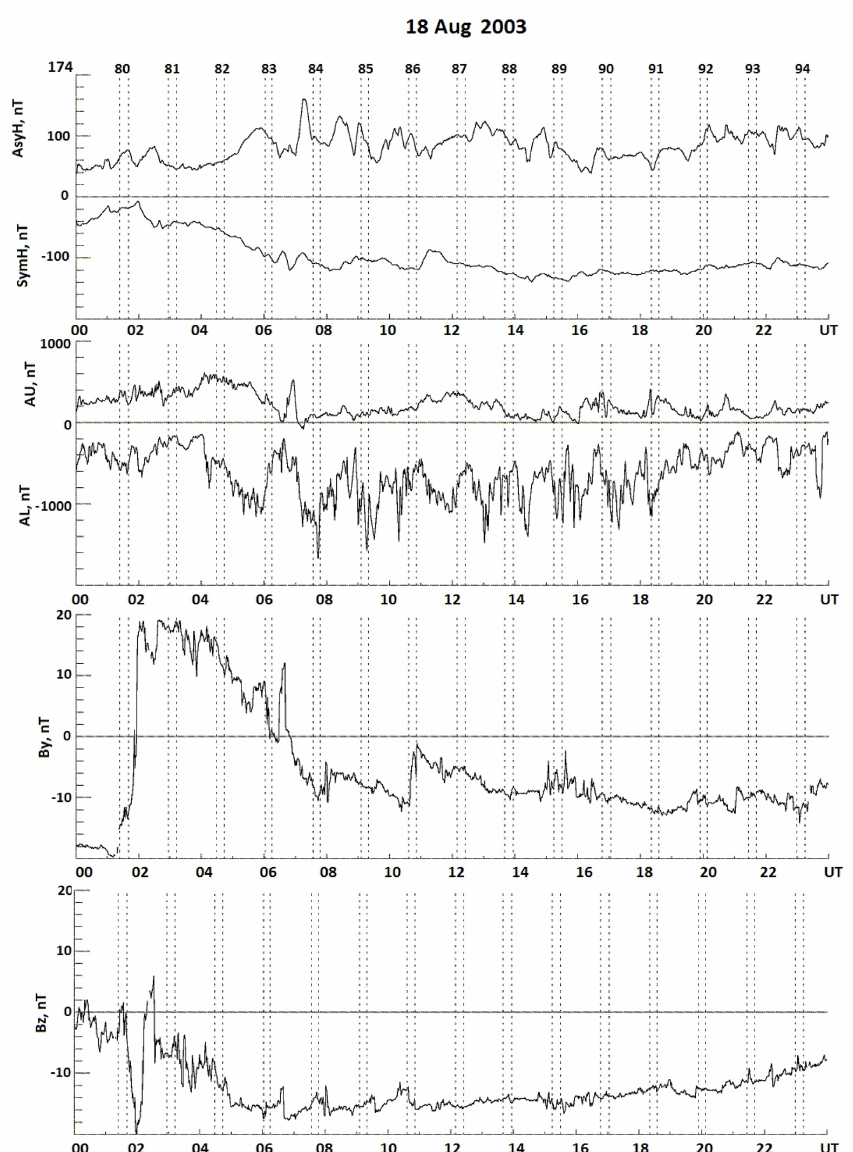
Figure A9. One-minute values of the AsyH, SymH, AU, and AL indices and of the B y and B z components of the IMF for the storm on 18 August 2003 (analysis interval 00:00–23:00UT, orbits 17480–17494). The time of each orbit and its orbit number are indicated as in Fig. 1 of the